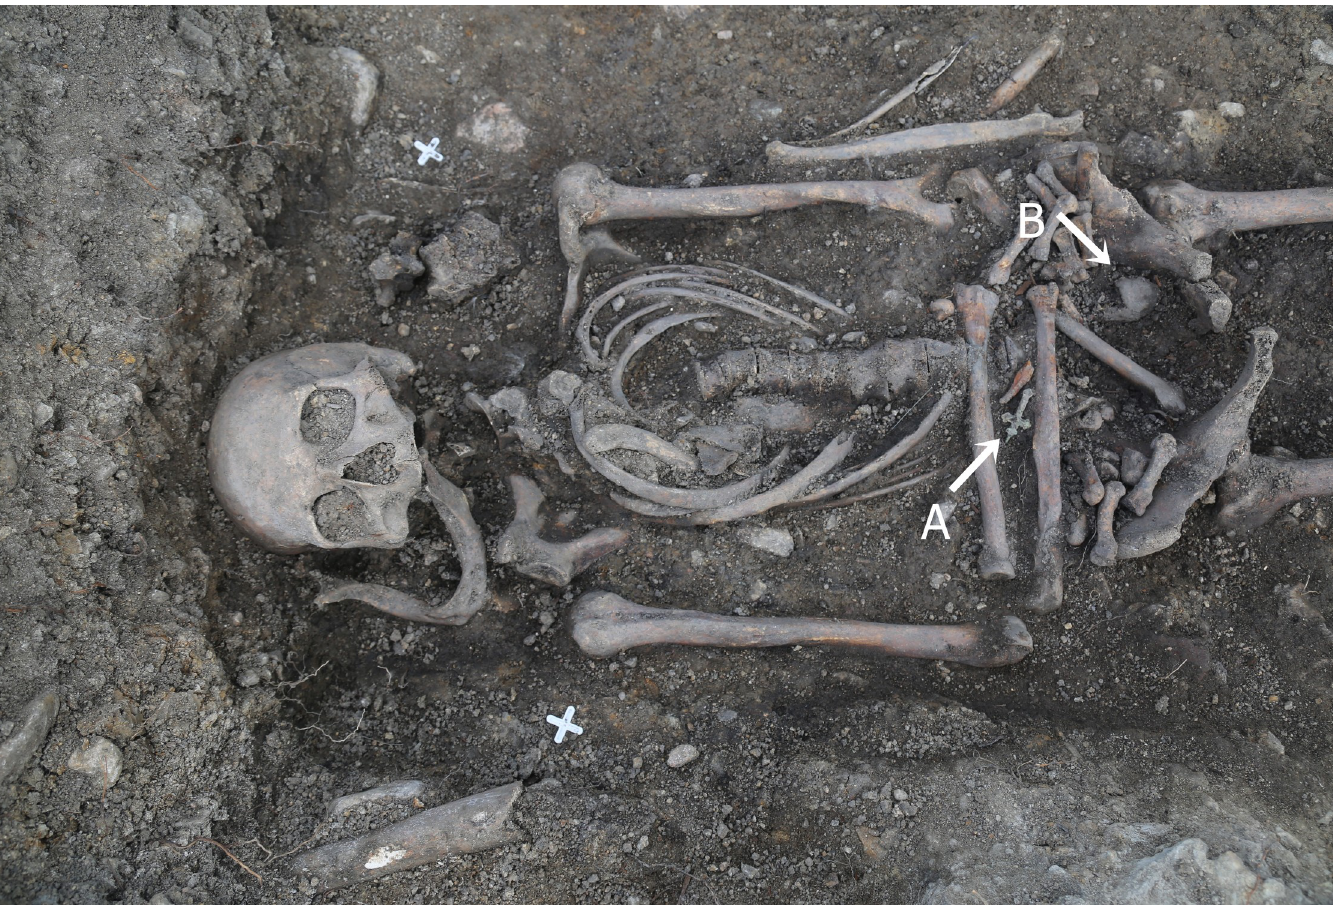
Fig 1. Burial no. 1095. A: Latin Cross. B: cystic object in left iliac fossa.